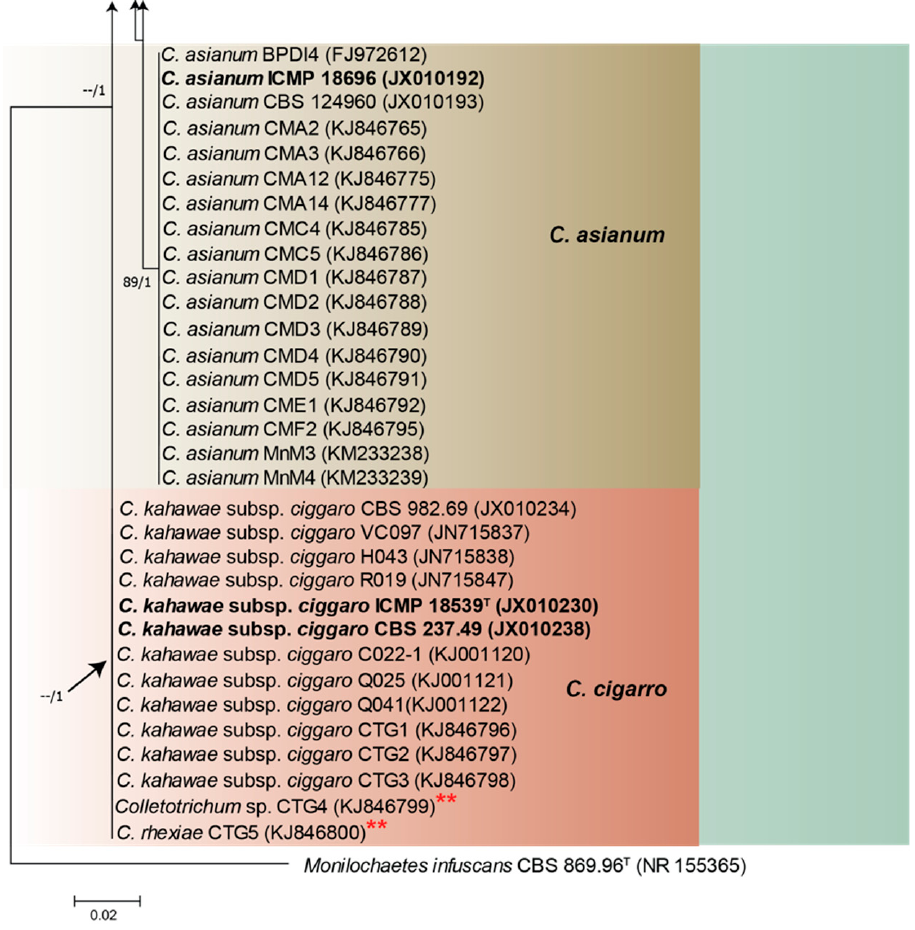
Figure 2. An ML tree of the gloesporioides clade that includes species reported in northern South America (Colombia, Ecuador, Peru, and Venezuela). The tree was created based on the alignment of ITS (434 bp). The GenBank accession numbers of sequences retrieved from the database are given in parentheses. Reference strains are shown in bold. Branch lengths are proportional to phylogenetic distance. The best substitution model for ML was determined to be T92+G. Bootstrap support values/Bayesian posterior probability scores above 70%/0.95 are indicated on the nodes. The tree was rooted to Monilochaetes infuscans CBS 869.96. T = Ex-type strain. ** Isolates are probably mislabeled in GenBank .